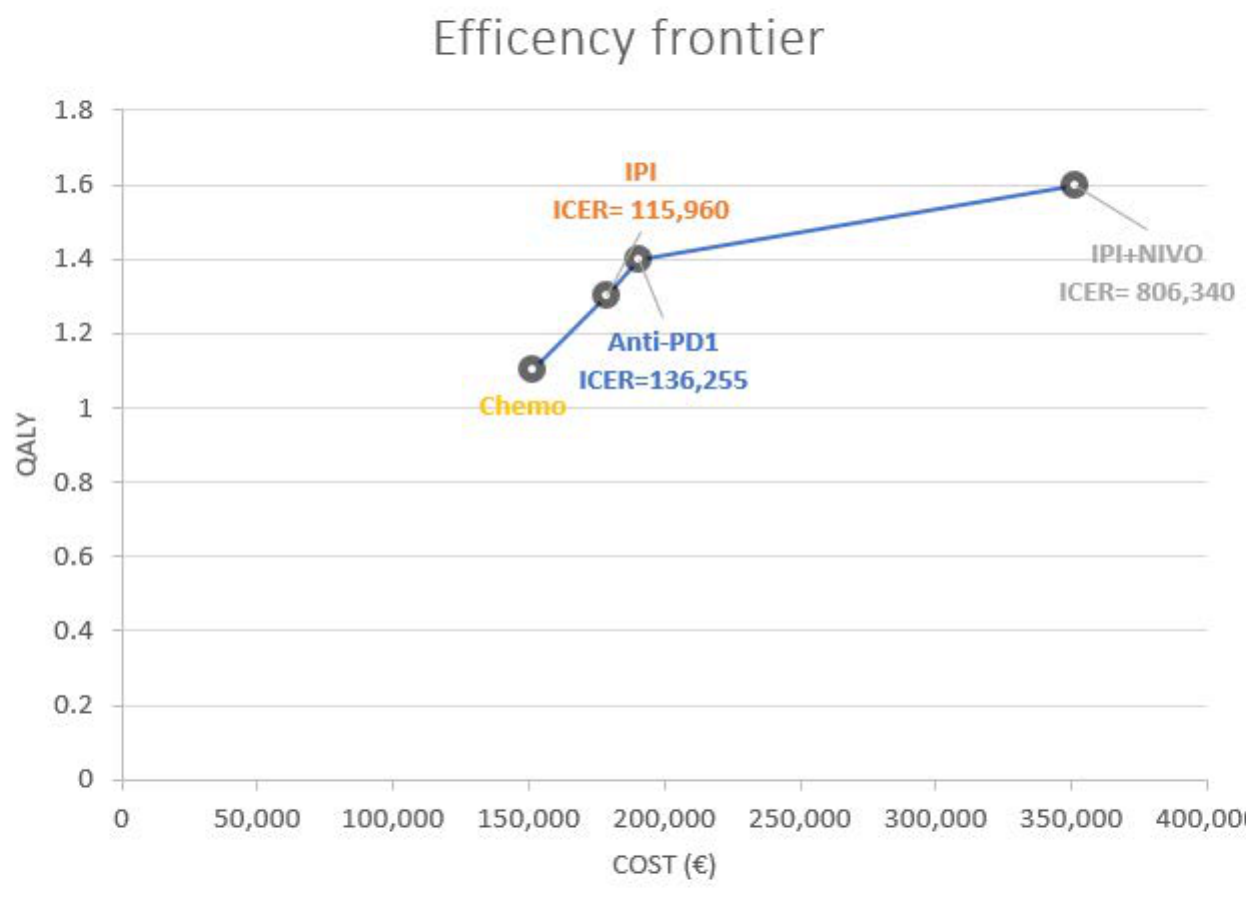
Figure 3. Efficiency frontier for the BRAF wild-type